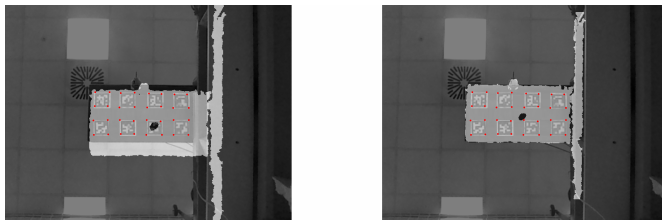
Figure 9. Kinect V1 depth and RGB images in grayscale ( Left ) Before mapping. ( Right ) After mapping.